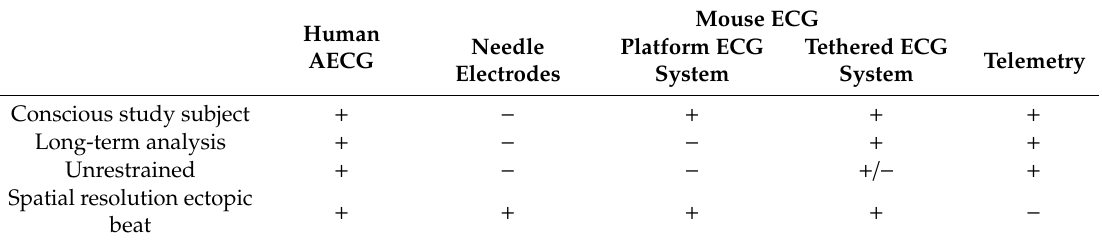
Table 1. Characteristics of human ambulatory electrocardiography (AECG) and ECG techniques available in mice.